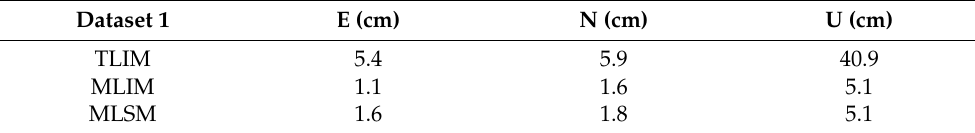
Table 1. GPS Positioning RMS statistical results for the rover station in dataset 1.